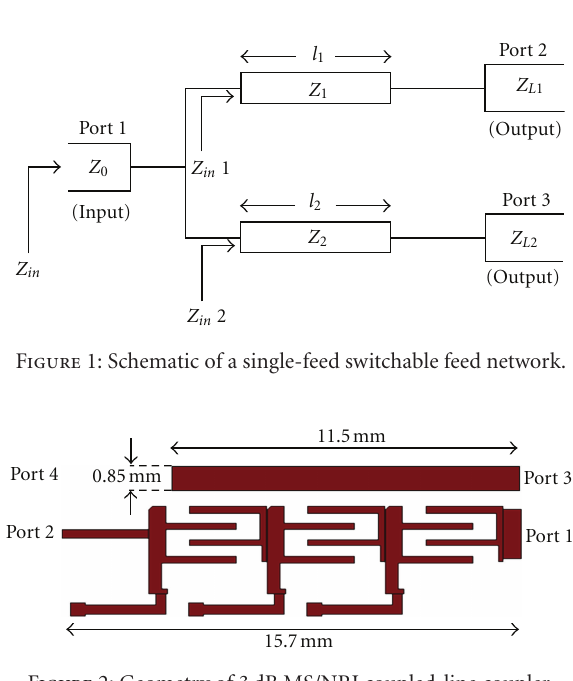
Figure 2: Geometry of 3dB MS/NRI coupled-line coupler. Table 1: The operation of the single-feed switchable feed